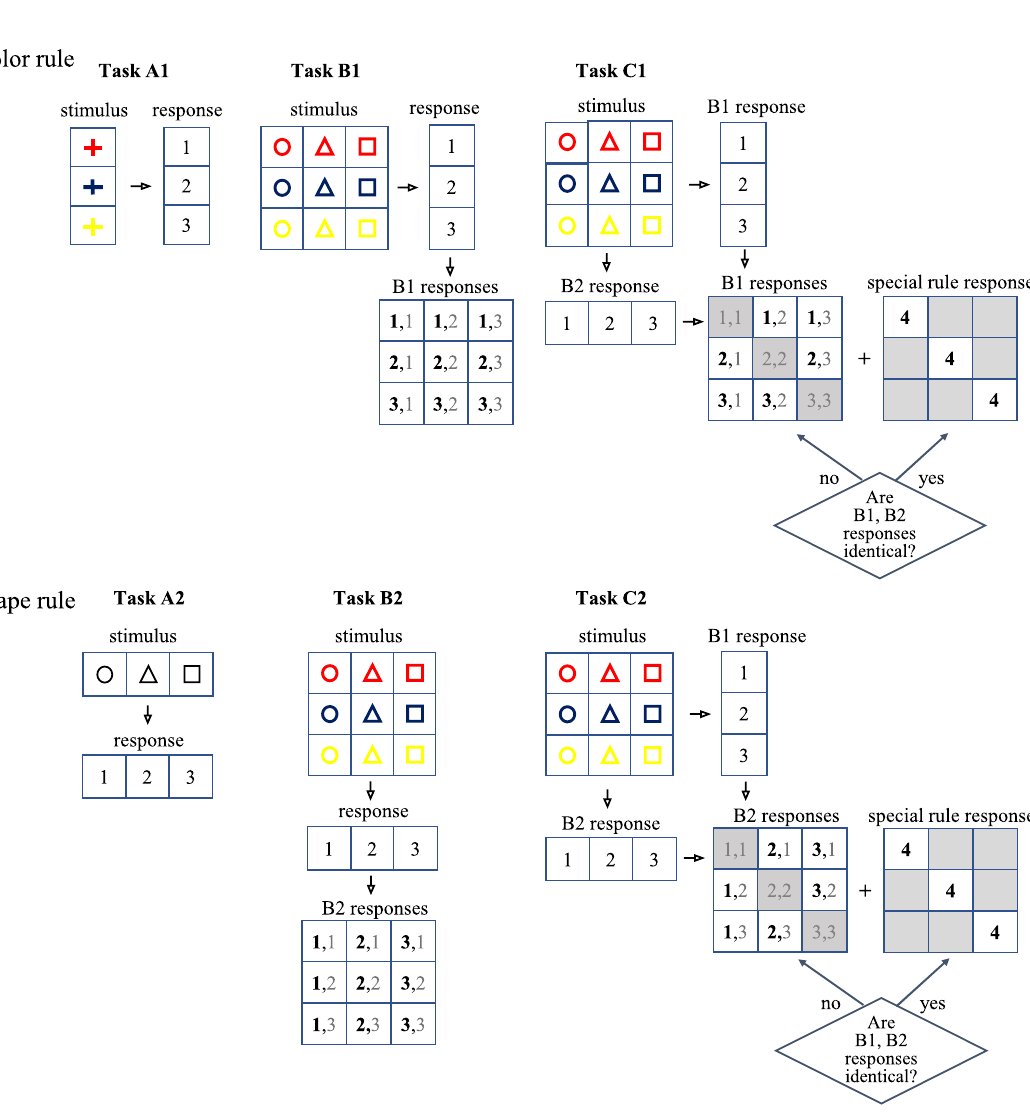
Figure 1. Diagrammatic representation of the task structure and cognitive operations for each rule and task. Task schemas depicting different operations of the three tasks and the relationship between the rules and responses according to the two-dimension stimuli (color and shape). In Tasks A1, B1, and C1, the main rule was keyed to color, and the response to the rule is drawn on the horizontal axis. In Tasks A2, B2, and C2, the main rule was keyed to shape, and the response to this rule is drawn on the vertical axis. Tasks A1 and A2 were direct responses to a one-dimensional stimulus. Tasks B1 and B2 were guided by the same rule as Tasks A1 and A2 but with more corresponding dimensions and stimuli. Tasks C1 and C2 comprised several steps, as follows: first, recall of each of the two rule-responses concurrently for the two-dimension stimuli; then, after evaluating these two responses, the special rule was applied if the responses were identical, otherwise the main rule was applied.